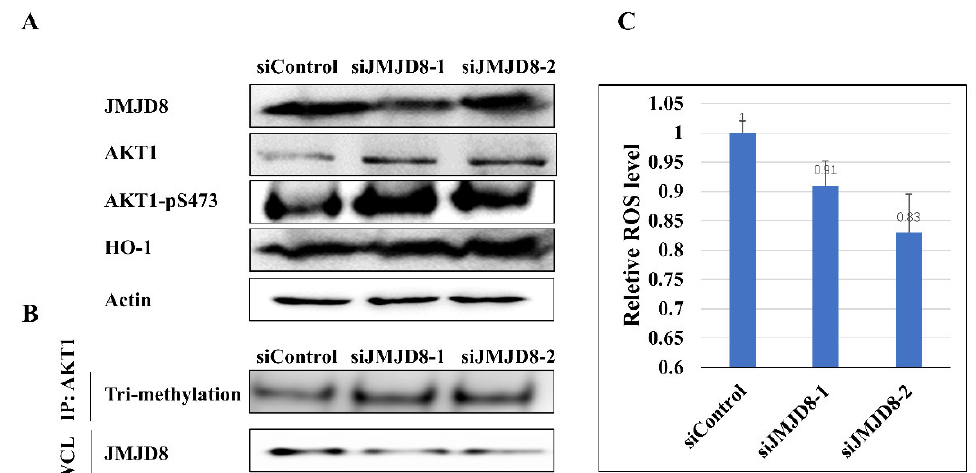
Figure 4. JMJD8 regulated the activity of AKT1 in H1299 cells. ( A ) Levels of AKT1, p-AKT(Ser473) and HO-1 were detected in JMJD8-knockdown cells. ( B ) Level of tri-methylation of AKT1 in JMJD8- knockdown cells. Cells were transfected with siJMJD8, and AKT1 plasmids and whole cell lysate (WCL) were collected for IP with AKT antibody, followed by IB analysis. ( C ) Ros level in H1299 cells was assessed. Knockdown of JMJD8 helped the remove ROS in cells.